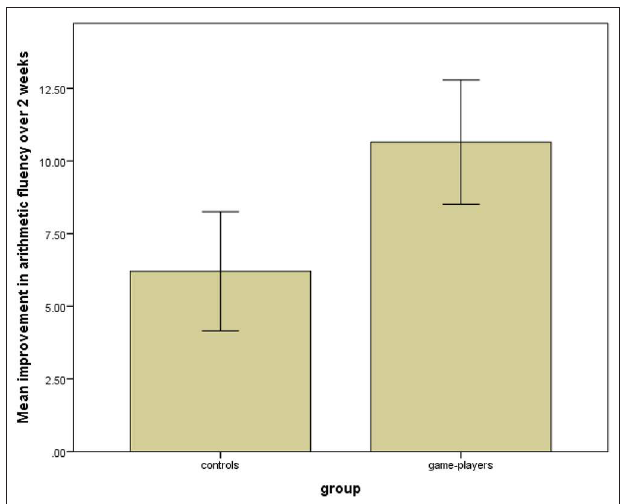
FIGURE 4 | Mean improvement in arithmetic performance following crossover (error bars represent ± 2